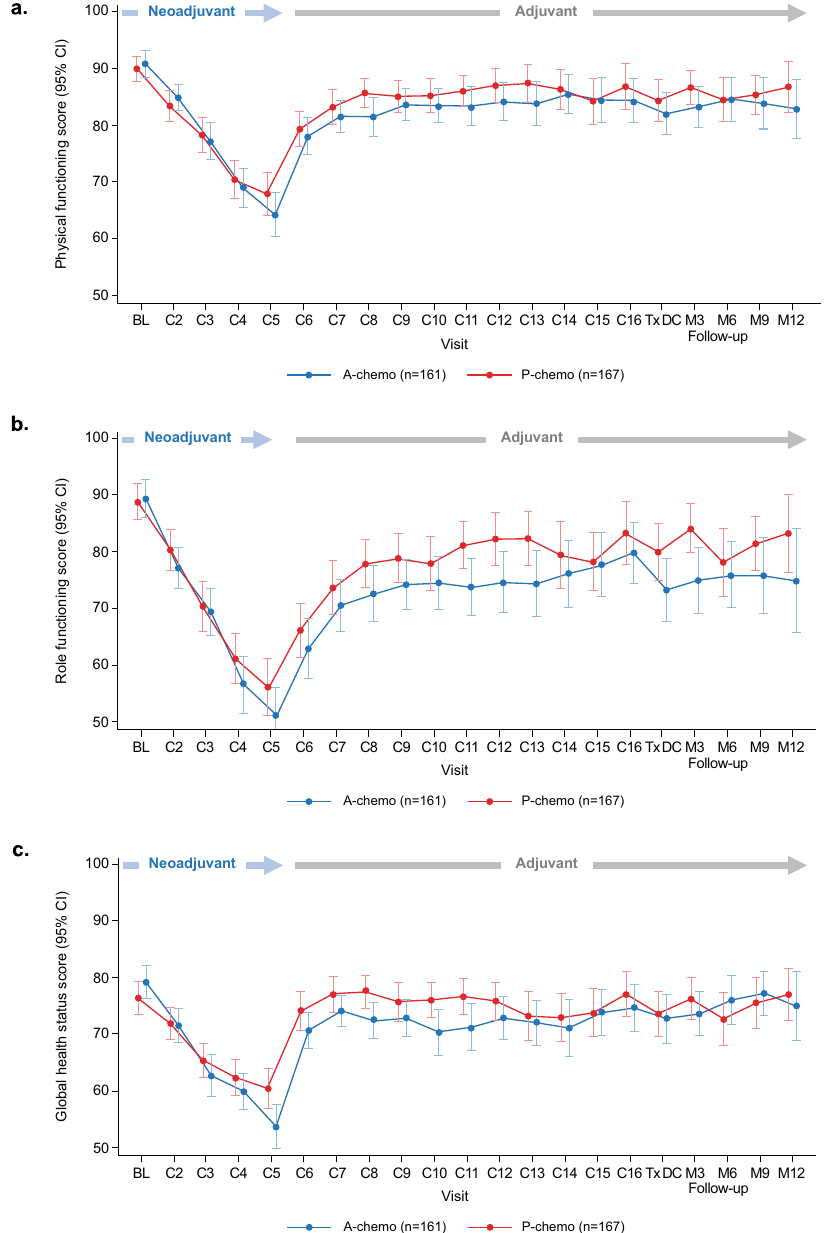
Fig. 1 Mean values at each time point for physical function, role function, and HRQoL. Error bars indicate 95% con fi dence intervals. Mean values at each time point for a physical function, b role function, and c HRQoL was measured using the EORTC QLQ-C30. A atezolizumab, C cycle, M month, P placebo, Tx DC treatment